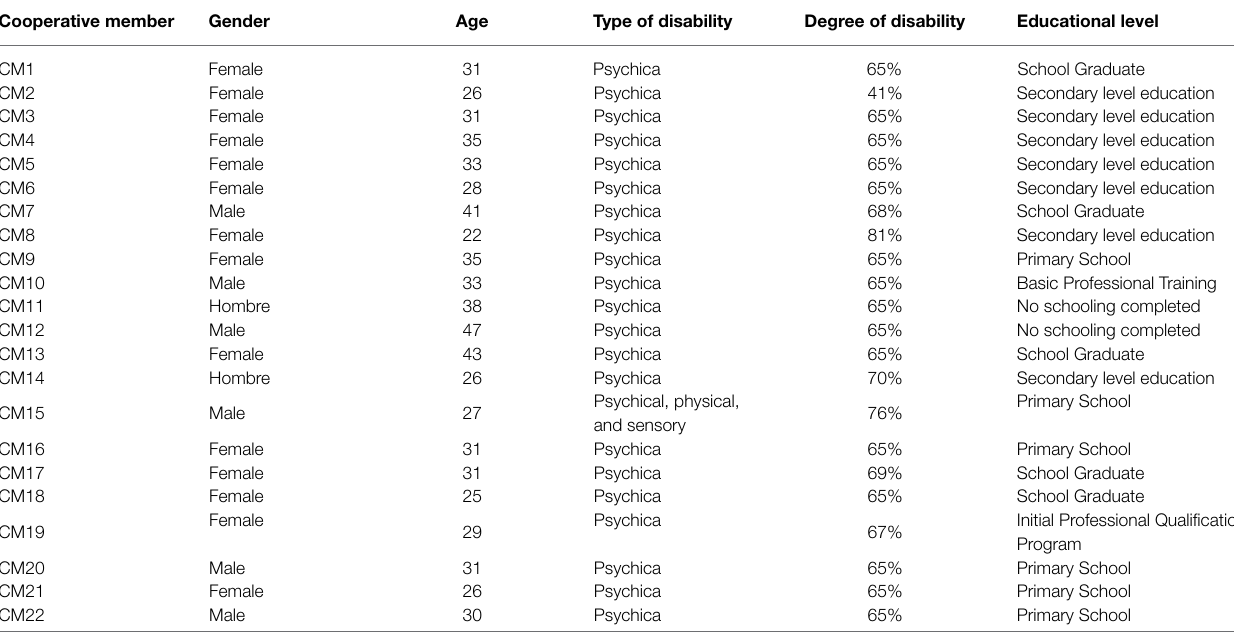
TABLE 1 | Cooperative members detail of Abono Café. Cooperative member Gender